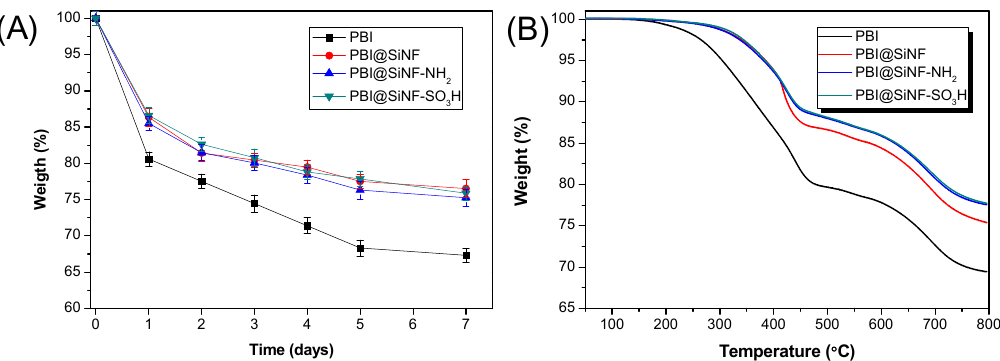
Figure 5. ( A ) Oxidative stability after Fenton (cid:48) s test and ( B ) thermal stability of composite membranes containing